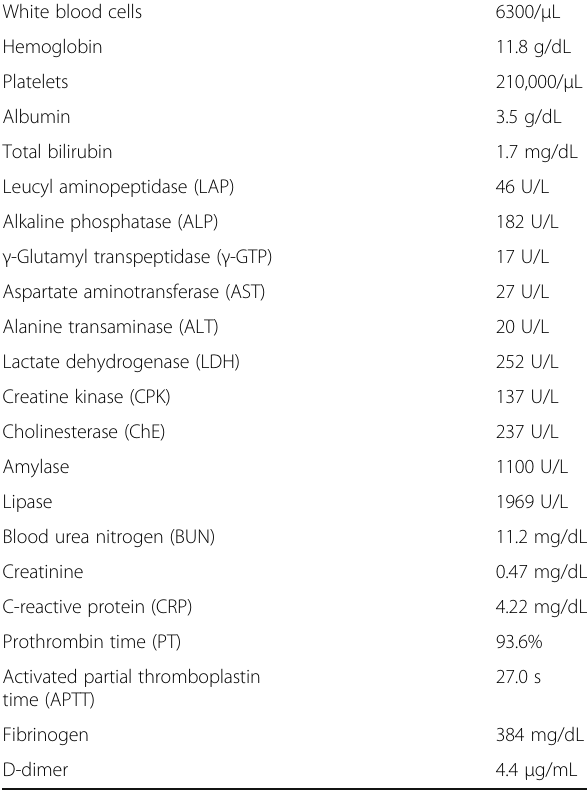
Table 1 Preoperative laboratory